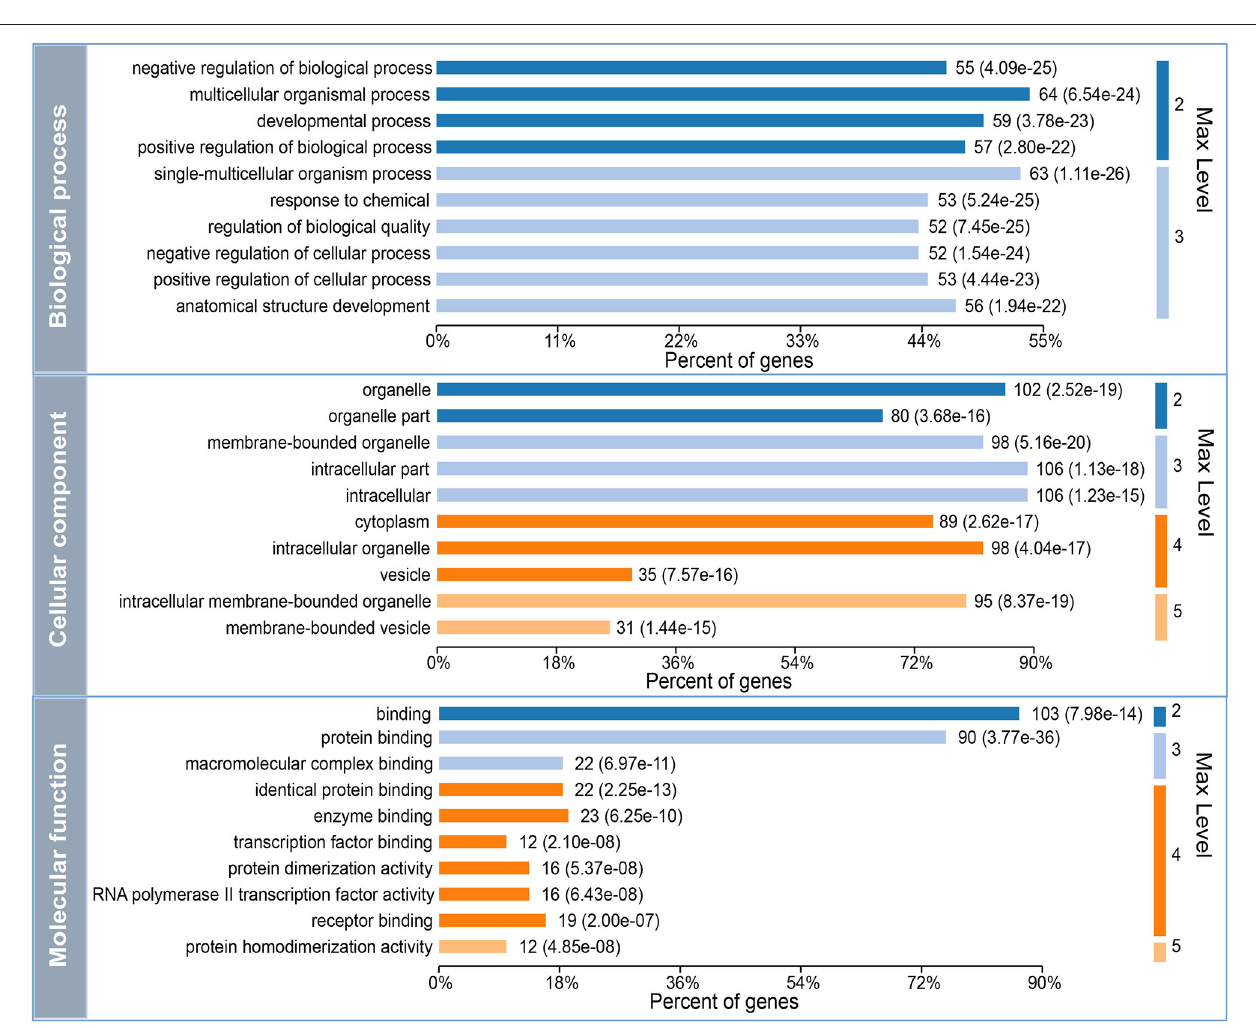
FIGURE 3 | Gene Ontology (GO) annotation for the 119 differentially expressed mRNAs (DEGs) that intersected with the target genes of differentially expressed miRNAs (DEMs). Max level means the maximal annotated level of this term in the GO graph (tree), and the number indicates the depth of the GO term level.